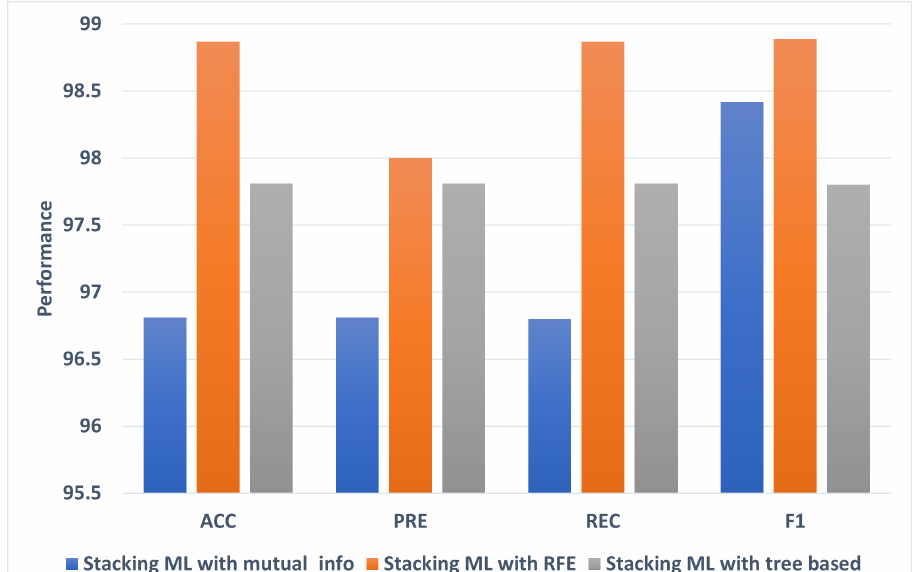
Figure 9. The best models for 70:30